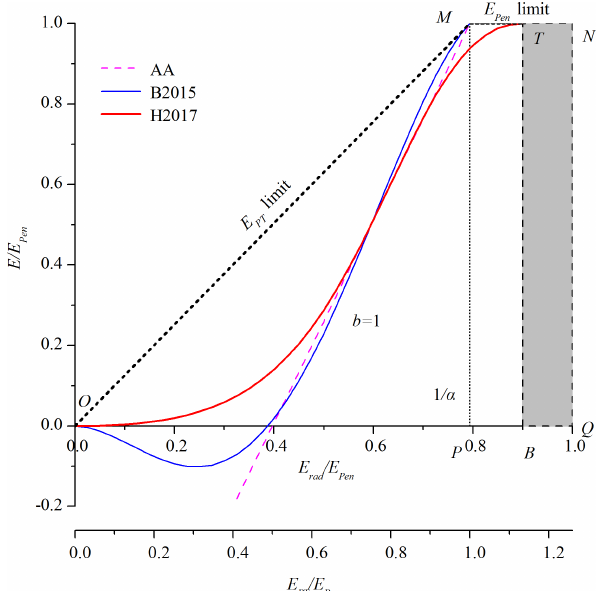
Figure 3. Generalized complementary functions in the state space ( E rad /E Pen , E/E Pen ): linear AA, polynomial B2015 and sig- moid H2017, with α = 1 . 26 and b = 1 · x min , and x max are set to 0 and 0.9, respectively, as revised from Han and Tian (2018a). OM is the edge at which E = E PT , MN is the edge where E = E Pen , M corresponds to the condition of the minimal advection evapo- ration where E PT = E Pen and N corresponds to the condition of the equilibrium evaporation where E Pen = E rad